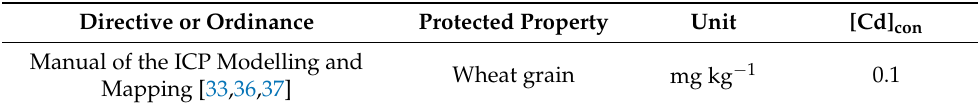
Table 12. Critical concentrations of cadmium in wheat.